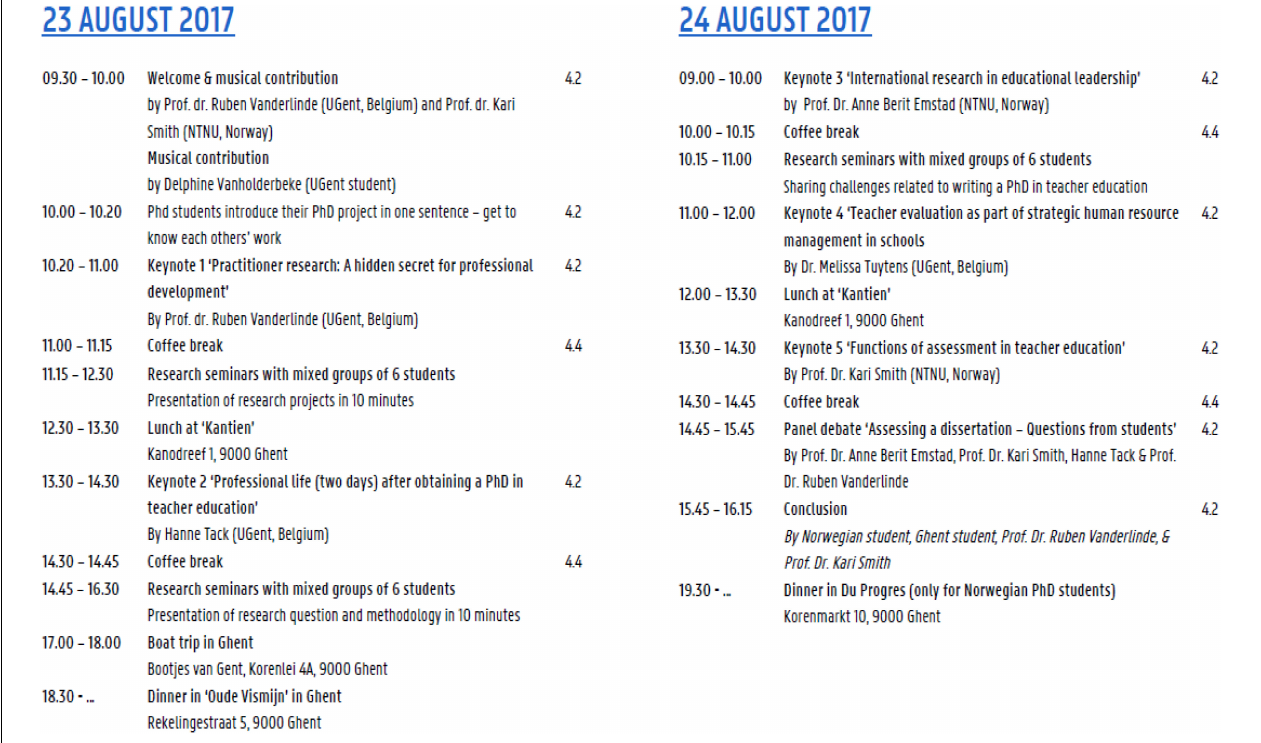
FIGURE 2 | Example of NAFOL international seminar at University of Ghent,